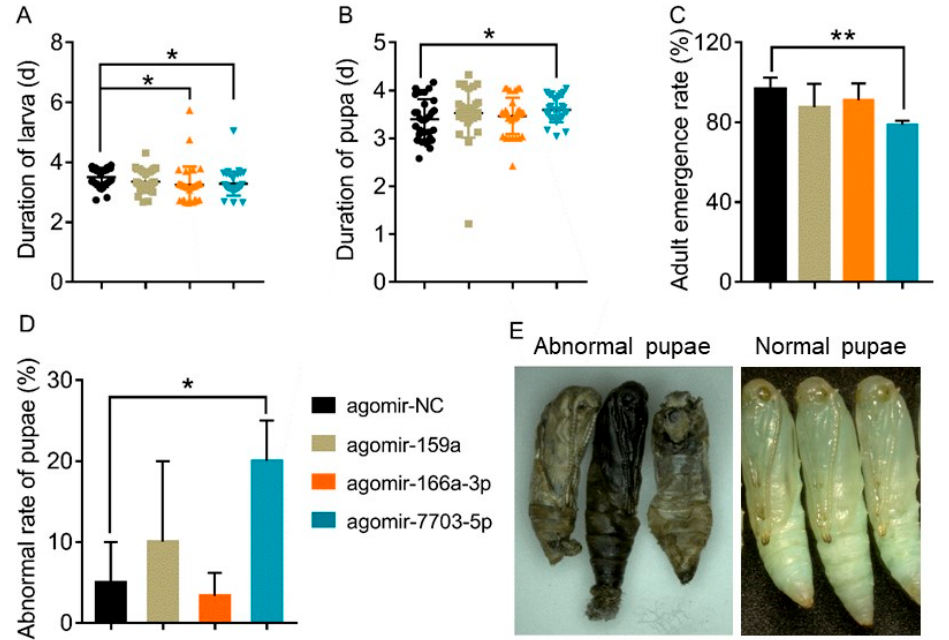
Figure 5. E ff ects of plant-derived miRNAs on the development of P. xylostella . ( A ) and ( B ). Larval ( A ) and pupal ( B ) durations after miRNA agomir treatments. Data were presented as mean ± SD (Student’s t test, * p < 0.05). ( C ) Adult emergence rates after miRNA agomir treatments. Data were presented as mean ± SD (Student’s t test, ** p < 0.01) ( D ) Percentages of abnormalities of G88 pupae after miRNA agomir treatments. ( E ) Abnormal pupae produced by miRNA agomir treatments compared with the control. Data were presented as mean ± SD (Student’s t test, * p < 0.05).